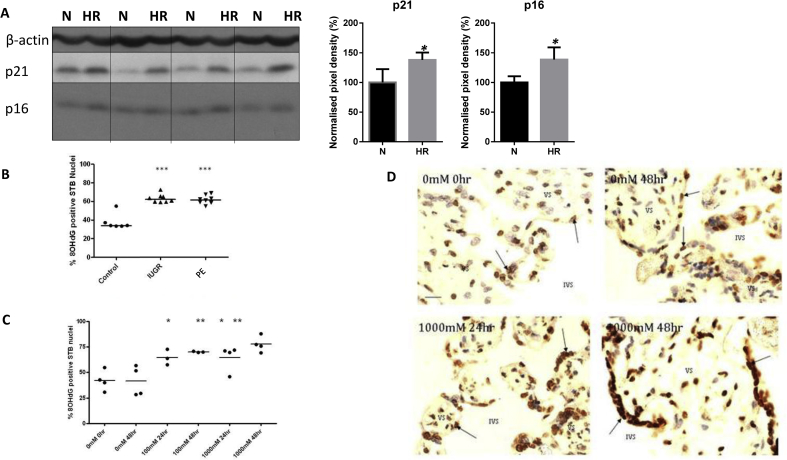
Evidence of senescence in placental explants challenged with oxidative stress of hypoxia-reoxygenation (A) or H2O2 (C–D) in vitro. A) Lysates from term placental explants (n = 4), which were cultured under normoxia (N, 10% O2) or hypoxia-reoxygenation (HR, 1–10% O2) for 20 h were immunoblotted with antibodies against p21 and p16. β-actin expression served to normalize gel loading. Normalized results (±SEM) are plotted, expressing normoxic controls as 100%. * Significant differences (P < 0.05, t-test). B-D) Immunoreactivity for 8-hydroxy-2′-deoxy-guanosine (8-OHdG), a marker of oxidised DNA, was examined in pathological placentas and in placental explants in vitro. B) Percentage of 8OHdG-positive syncytiotrophoblast nuclei was quantified in pathological and control placentas. Placentas from early onset IUGR (N = 5) and PE (N = 7) have increased proportions of 8OHdG-positive STB nuclei compared to gestational age-matched controls (pre-term controls, N = 5). Immunohistochemistry was used to detect 8OHdG-positive STB nuclei. Bar represents the group mean (Tukey's post hoc ***p < 0.0001). C-D) Quantification of 8OHdG-positive syncytiotrophoblast nuclei after H2O2 treatment (n = 3, 4). Term placental explants were cultured with 0–1000 mM H2O2 for 24–48 h, and fixed for immunohistochemical detection of 8OHdG. A higher proportion of 8OHdG-positive STB nuclei were observed in explants cultured in 1000 mM H2O2 when compared to control explants. Unpaired t-test between treatments showed statistically increased percentages of 8OHdG-STB in 100 mM and 1000 mM H2O2 after both 24 h culture, compared to the 0 mM 0hr control (*p < 0.05). There was an increase in the proportion of positive STB nuclei in 1000 mM after 48 h compared to the 0 mM 48hr control (**p < 0.001). (VS, villous stroma; IVS, intervillous space; arrows indicate positive STB nuclei; scale bar 20 μm).